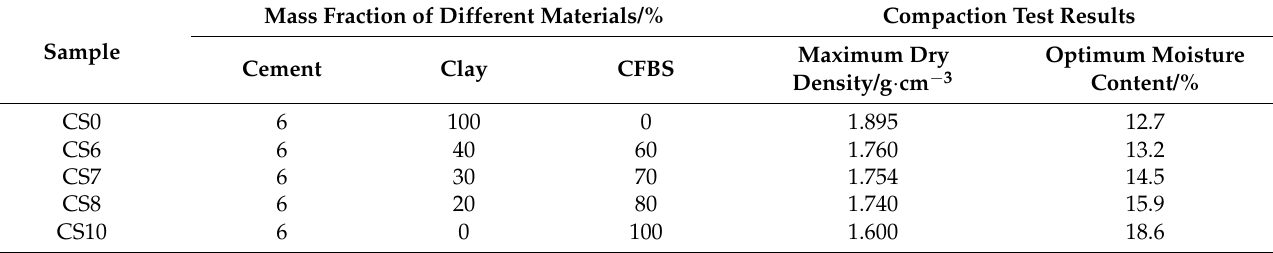
Table 3. Mix proportion and compaction test